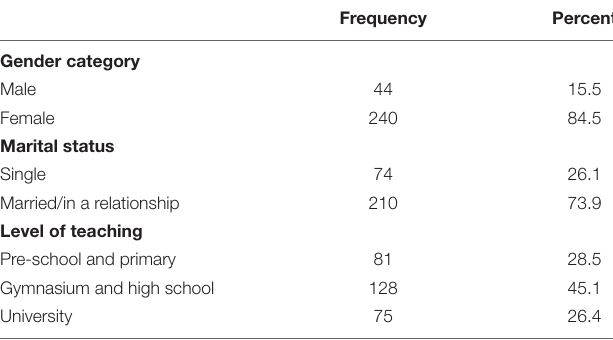
TABLE 1 | The demographic profile of respondents ( N =